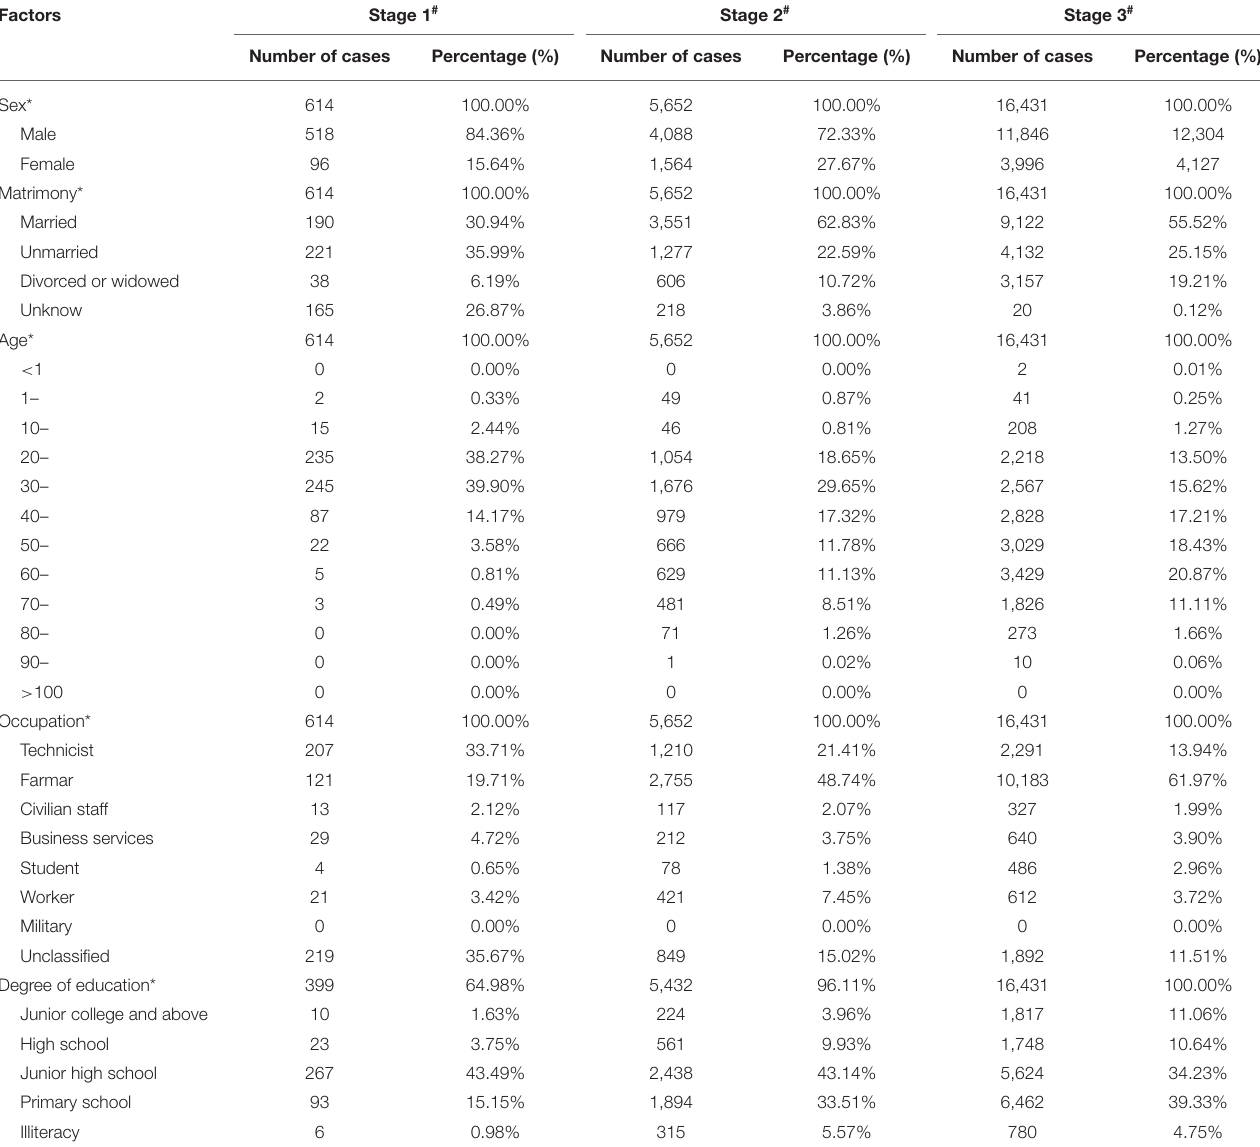
TABLE 4 | The distribution by people of HIV in three stages in Nanning from January 2001 to May